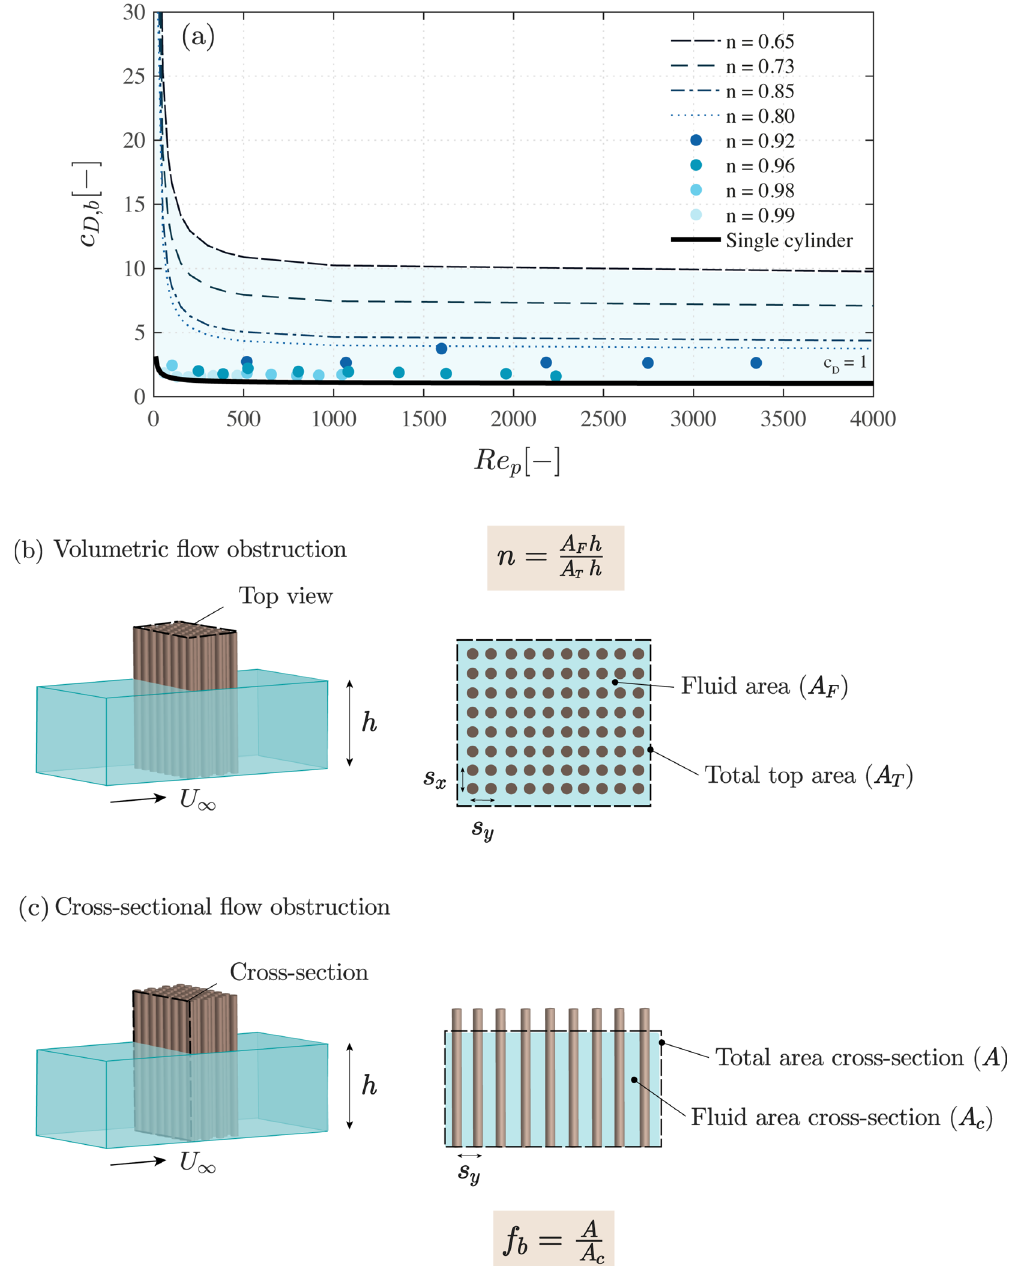
Figure 2. ( a ) Bulk drag coefficient values ( c D , b ) from the literature (including blockage and sheltering effects) as a function of the Reynolds number based on the cylinder diameter and pore velocities ( Re p ). The shaded blue area shows the region of variation of c D , b . The data was collected for arrays of emergent and smooth circular cylinders in a current. The arrays fully covered the cross-section of the flume. The exact values of porosity, cylinder diameter, flow velocities, and bulk drag coefficient are provided in Table 1. The measurements with volumetric porosities between n = 0.92 and 0.99 were obtained from Tinoco and Cowen 22 , and the fit lines for n = 0.65–0.80 from Tanino and Nepf 21 . ( b ) Definition of the volumetric porosity n , given as the ratio between the hA . ( c ) Definition of the blockage factor f b , given as the ratio hA F over the total volume V fluid volume, V F = = between the total cross-sectional area A of the array and the constrained flow section, A c